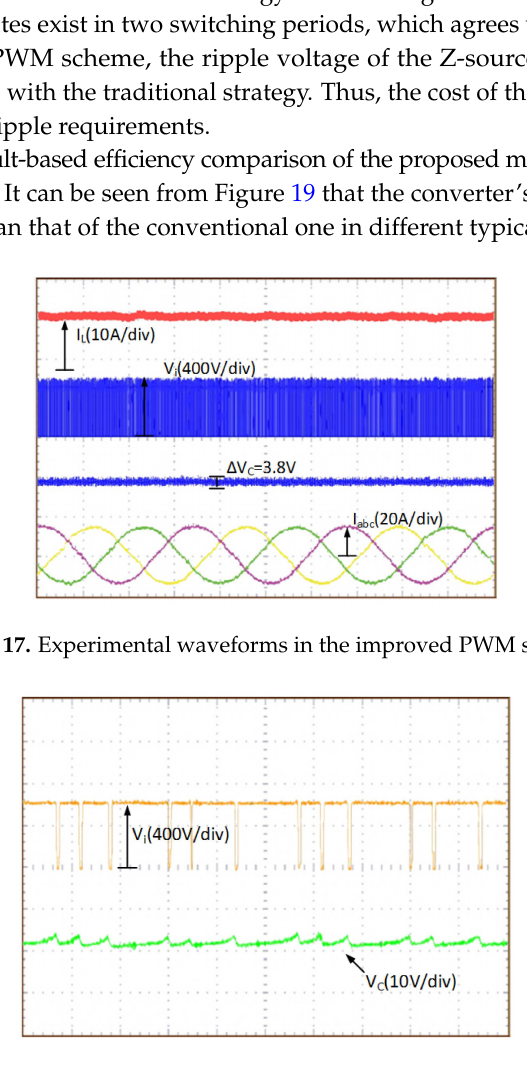
Figure 18. Amplified waveforms of the input voltage of the inverter bridge and the Z-source capacitor voltage corresponding to Figure